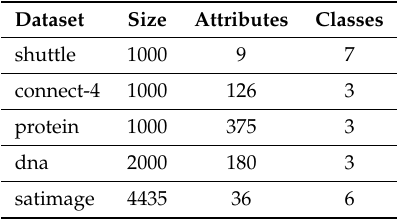
Table 4. Binary datasets in the experiment.